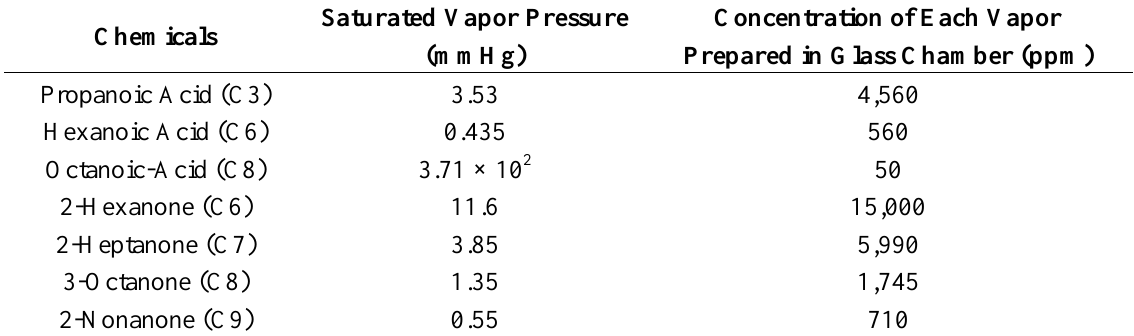
Table 1. The saturated vapor pressures of constituent odorants and concentrations of each vapor generated in desiccator. Each saturated vapor pressure is presented on the websites of Guidechem. The concentrations were calculated according to the saturated vapor